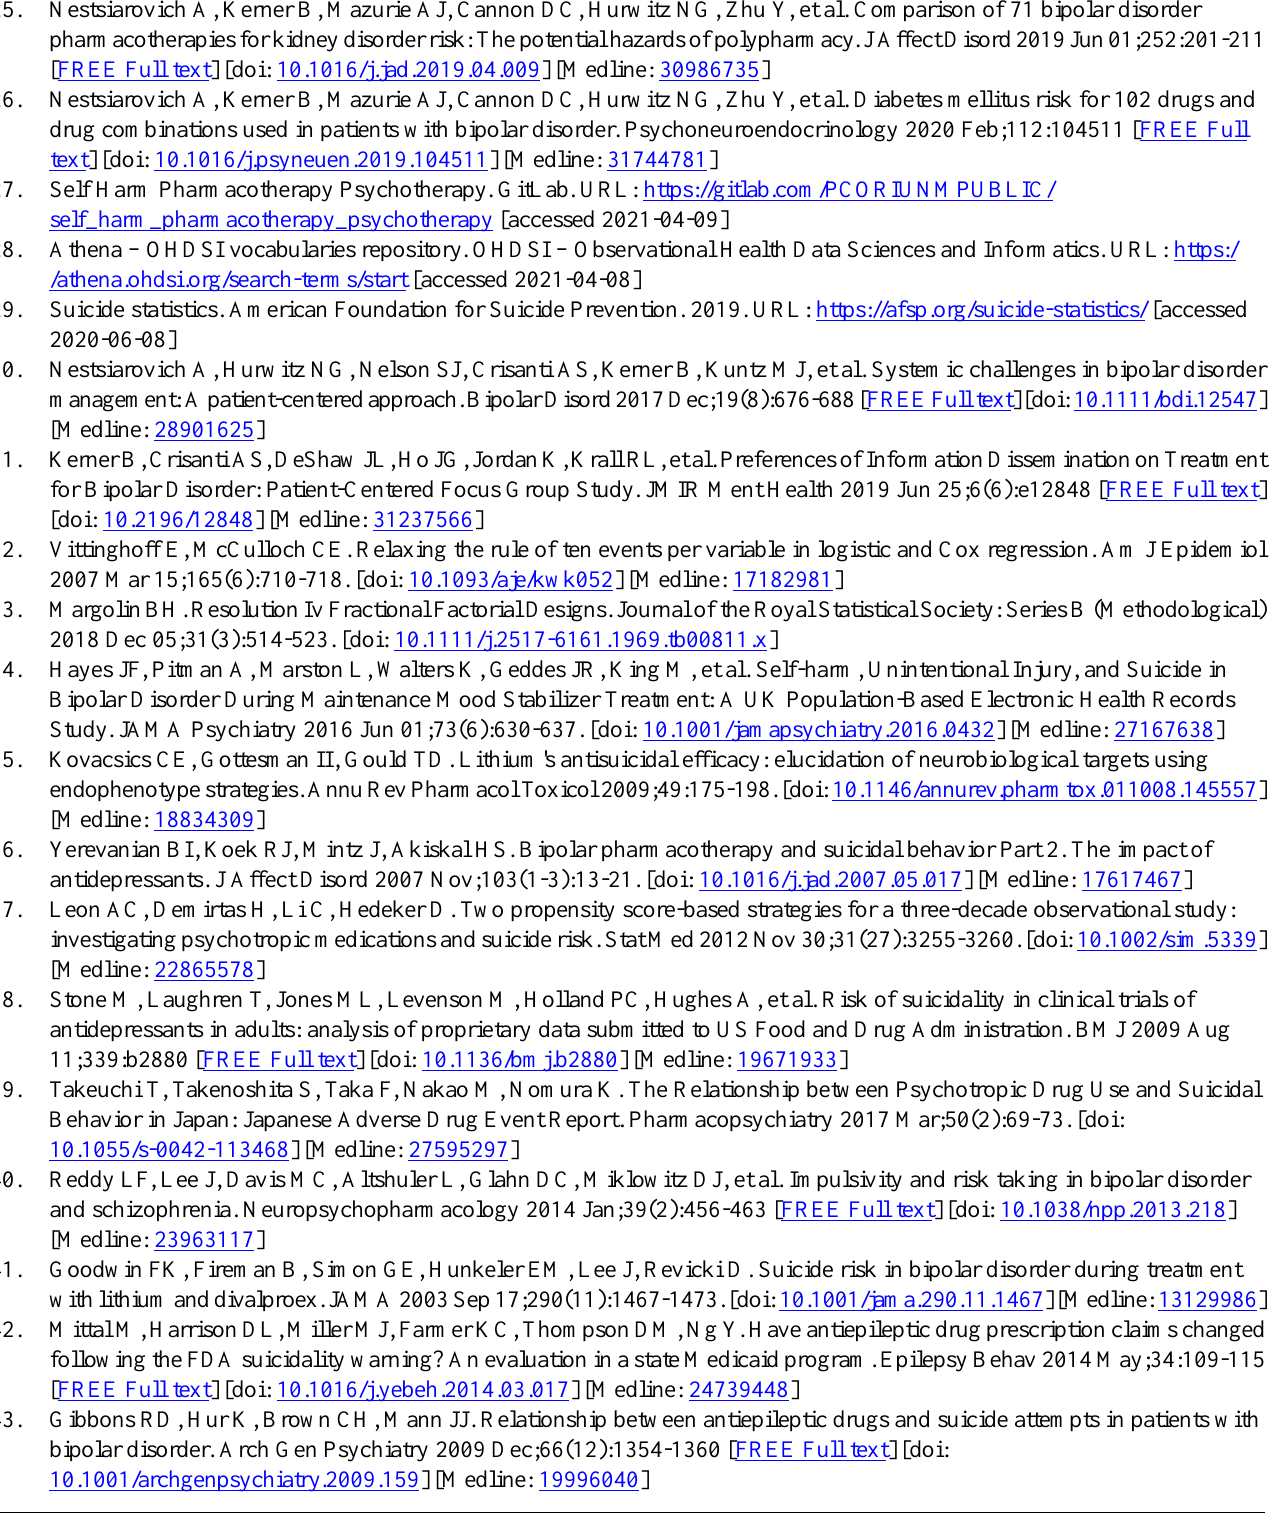
FDA: US Food and Drug Administration FGA: first-generation